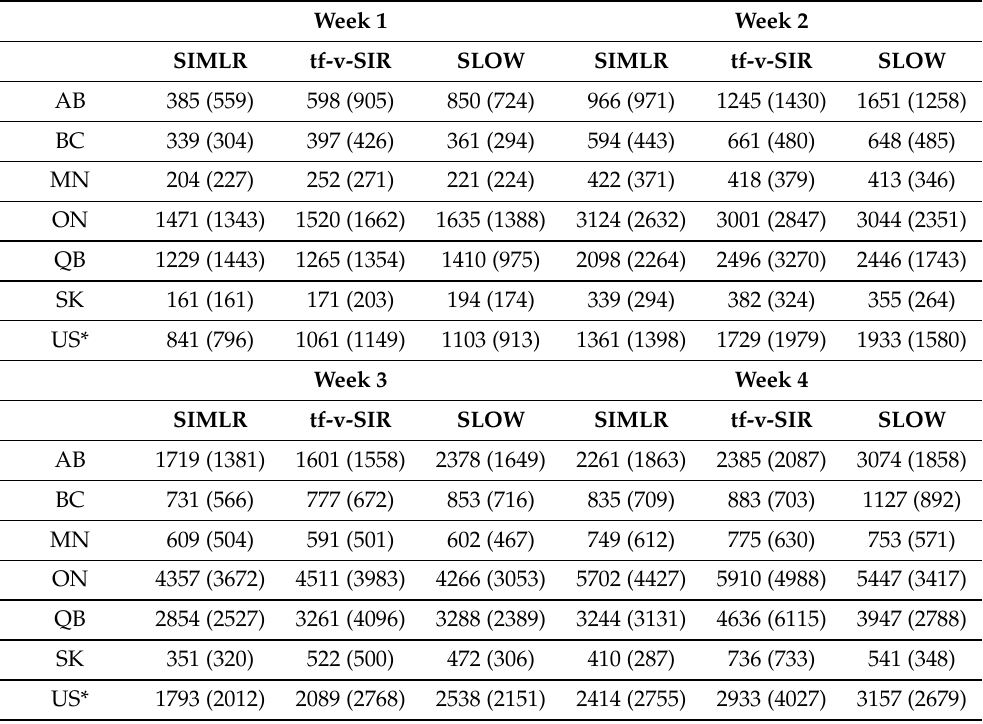
Table 2. MAE of the six biggest provinces in Canada and United States as a country, one- to four-weeks in advance. The number in parenthesis is the standard deviation. For the case of the US the number of cases was divided by 100.